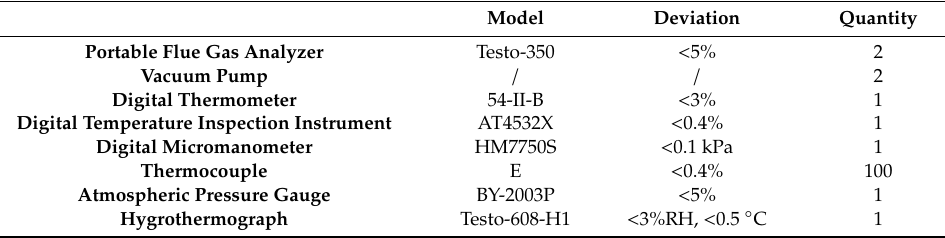
Figure 4. Simulation error histogram of APH. Table 2. Main experimental setup and equipment for the